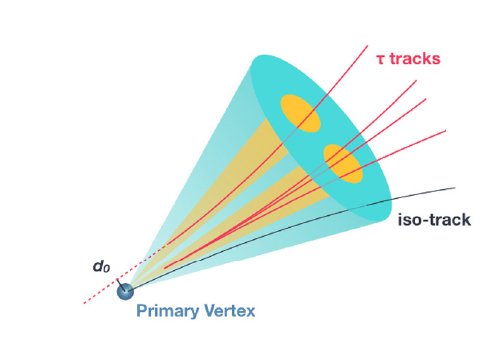
Figure 1. Schematic representation of a di- τ object: the large blue cone is the di- τ seeding jet while the two smaller yellow cones are the two leading sub-jets. Tracks found within a cone of size ∆ R = 0 . 2 around the sub-jet axis are matched to charged pions produced in hadronic decays of τ -leptons, while other tracks found in the isolation region are labelled as ‘iso-tracks’. The closest distance d 0 in the transverse plane between the primary vertex and the leading track matched to a sub-jet is also shown for